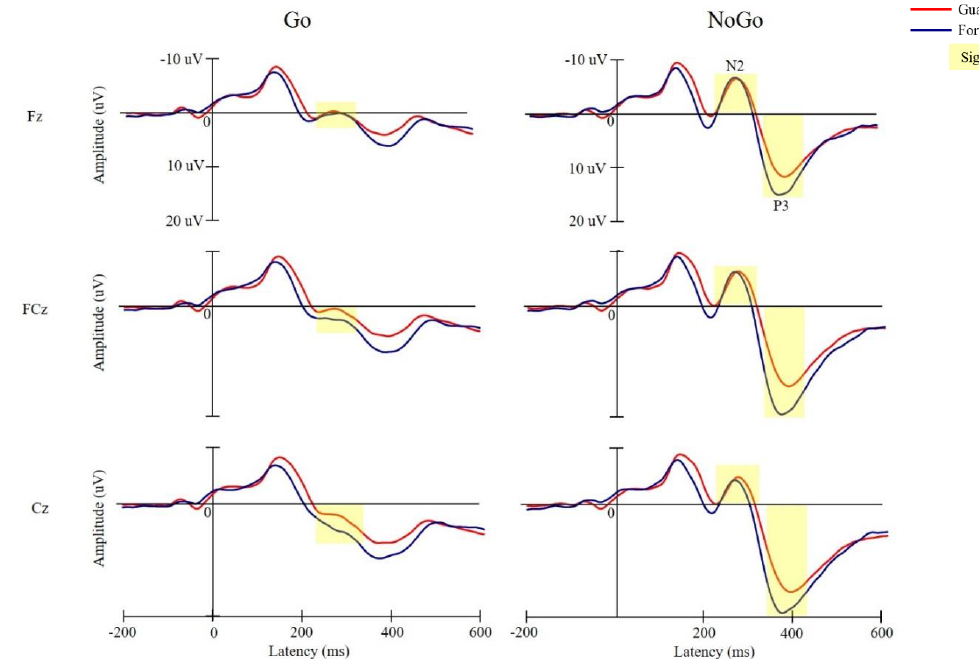
Figure 3. Grand-average ERPs for the Go and NoGo conditions for the Fz, FCz, and Cz electrodes in the guards and forwards groups (red line: guards group; blue line: forwards group).